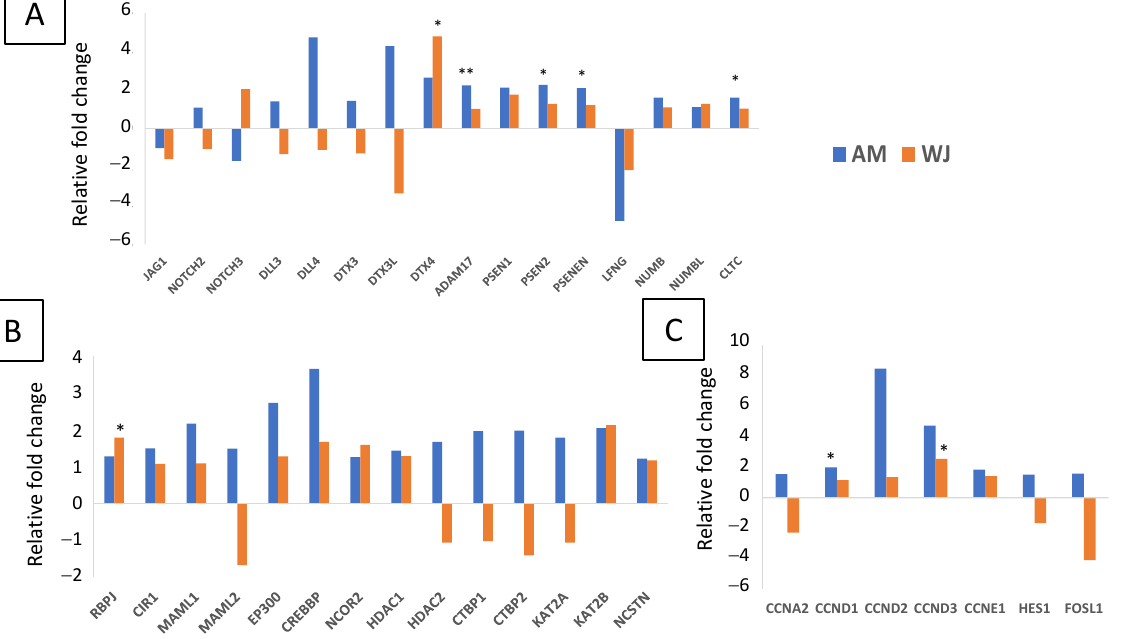
Figure 6. Differential expression of genes associated with Notch signalling pathways in AM- and WJ-MSCs during osteogenesis. ( A ) Ligands, receptors, ubiquitin E3 ligases and proteases; ( B ) other coregulators; and ( C ) downstream target genes. Asterisks (*) and (**) represent statistical significance of p < 0.05 and p < 0.005, respectively.